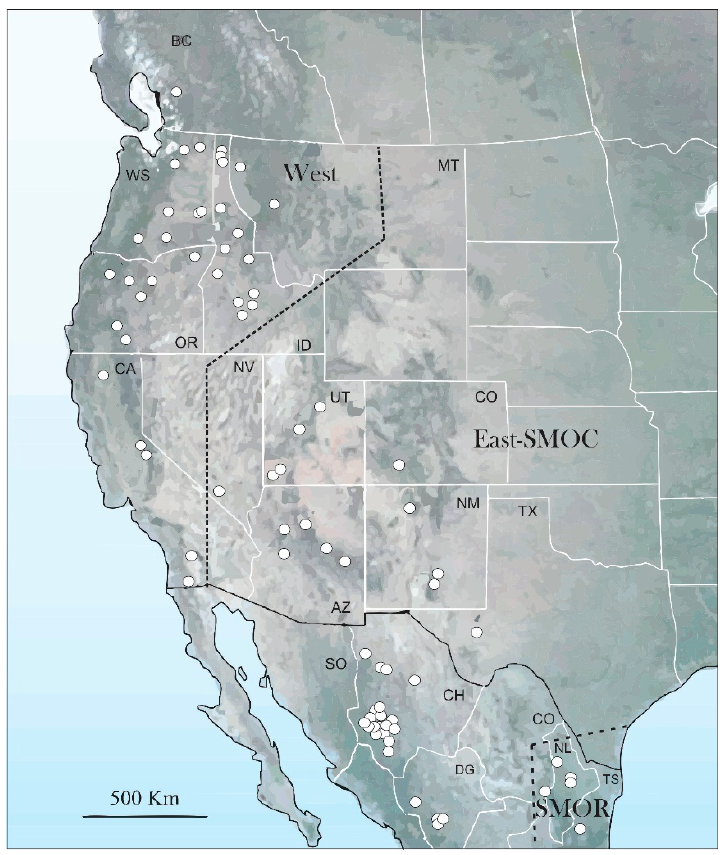
Figure 1. Distribution map, and populations analyzed across of distribution range of D . brevicomis .